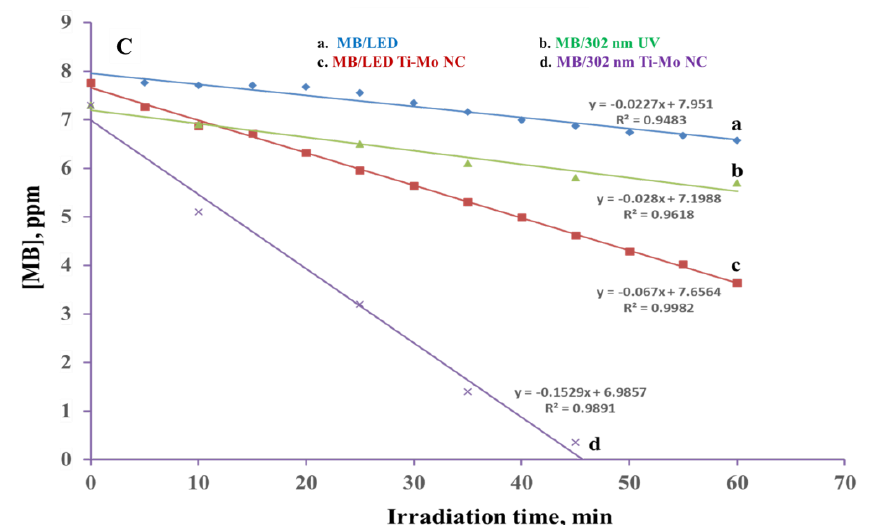
Figure 11. MB irradiated with 75 W LED white and 302 UV lights: ( A ) The SSLS of MB in the presence of Ti − Mo NC irradiated with 302 nm light for various times; ( B ) UV − Vis spectra of the MB/Ti − Mo NC irradiated with 302 nm UV for various times; and ( C ) photodegradation profile of MB alone irradiated 75 W LED (a) and 302 nm (b) lights along with the MB/Ti − Mo NC irradiated with LED light (c) and 302 nm UV (d).